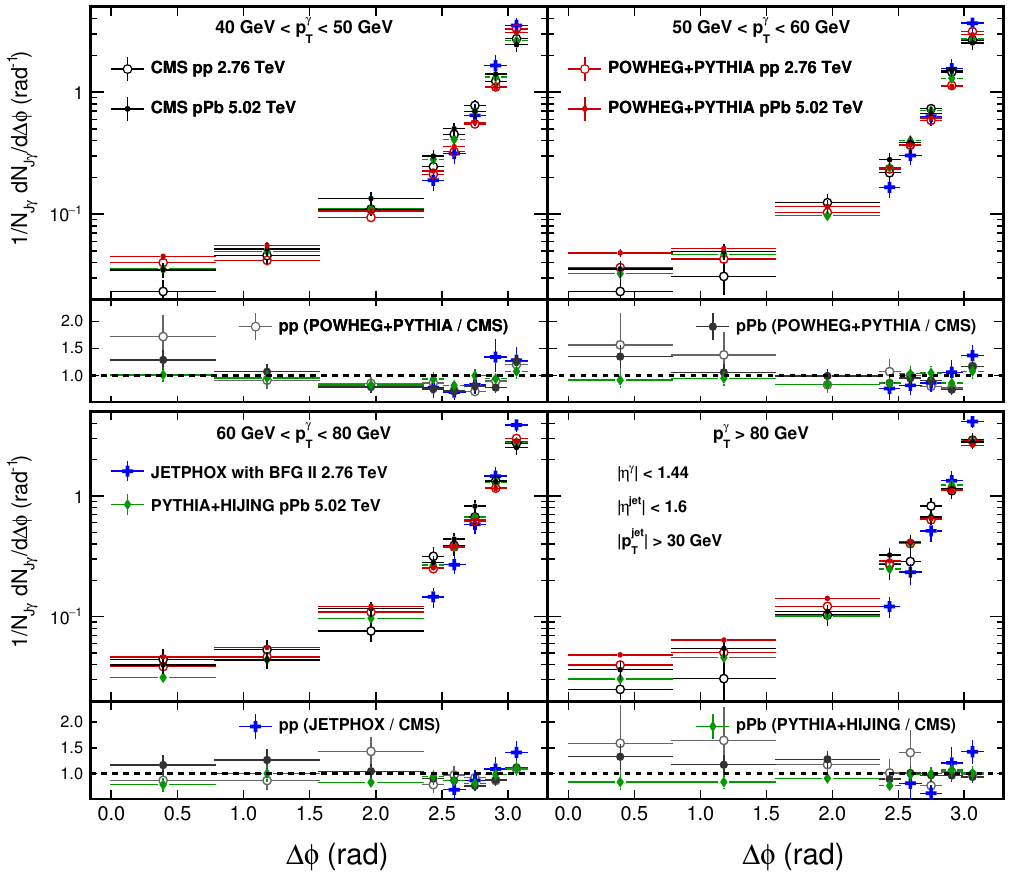
Figure 6 . Relative azimuthal angle distributions of jets and photons in pp (open circles) and pPb (full circles) collisions at the LHC with a centre-of-mass energy per nucleon of and 5.02 TeV, respectively, in four di(cid:11)erent bins of photon transverse momentum. CMS 2013 data (black) are compared to predictions in LO with PYTHIA+HIJING (green), NLO with JETPHOX (blue), and NLO+PS with POWHEG+PYTHIA (red). The lower panels show the ratios of theory over data for pp (open circles and blue crosses) and pPb (full circles and green